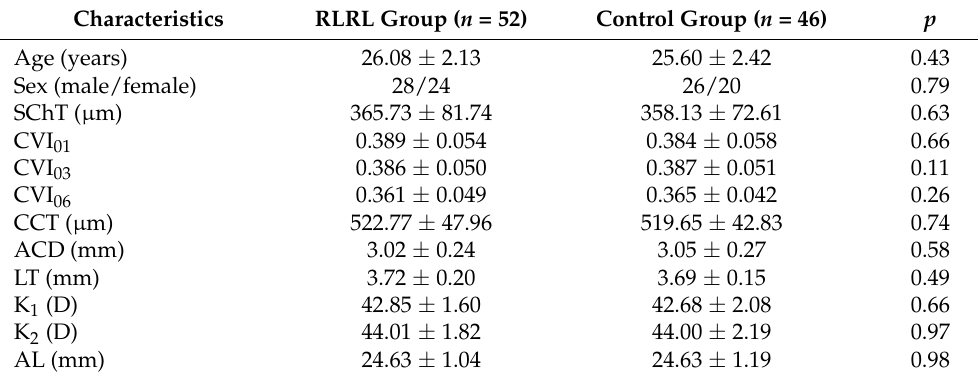
Table 1. Demographics and baseline ocular characteristics between the RLRL group and control group (mean ±